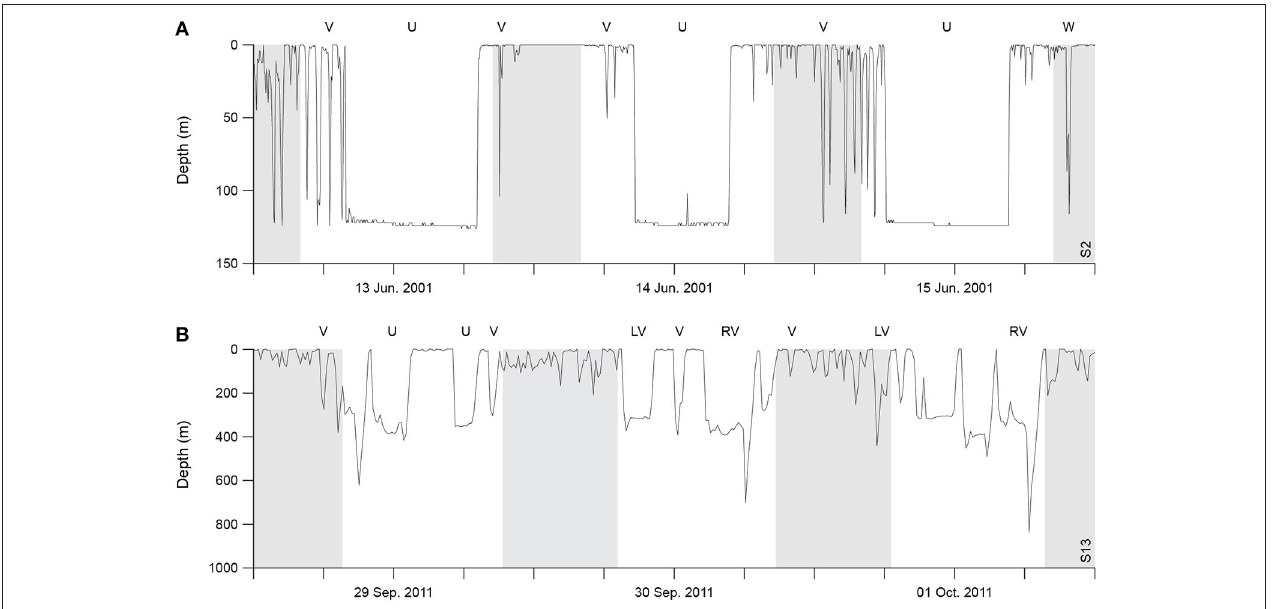
FIGURE 1 | Time-depth profiles of the five dive shape classes considered in this study. The dive classes were commonly performed by both basking (A) and blue (B) sharks; shaded areas denote night-time.